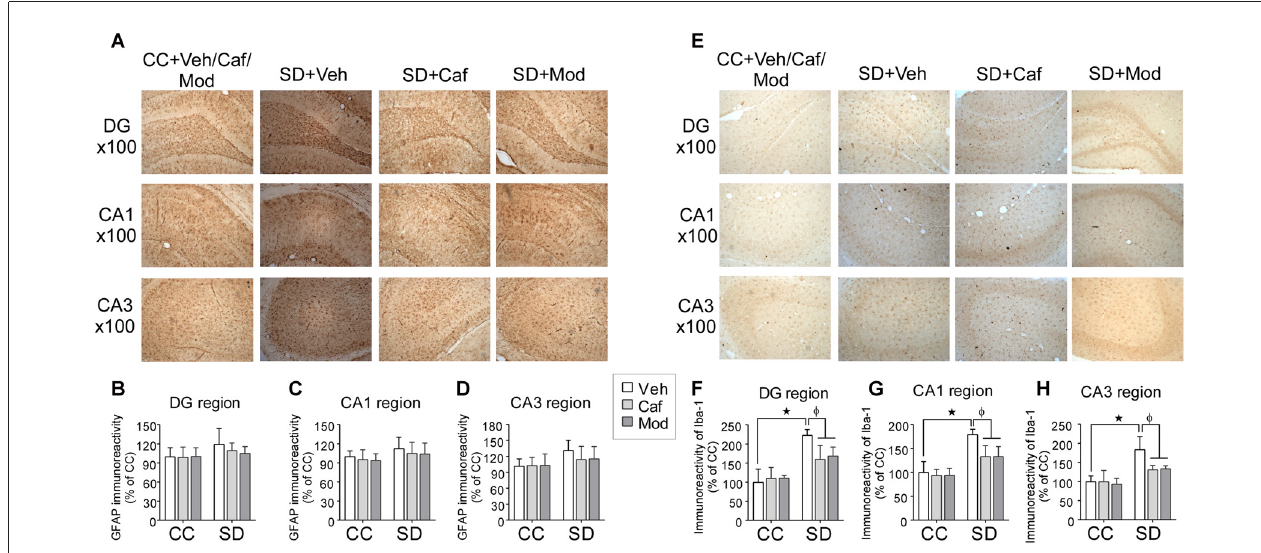
FIGURE 5 | Caffeine or modafinil treatment inhibited the glial cell immunoreactivity in rat hippocampus following SD. (A) Representable image of astrocytes expression in DG, CA1 and CA3 regions of the hippocampus. Glial fibrillary acidic protein (GFAP) immunoreactivity quantification in (B) DG region; (C) CA1 region; (D) CA3 region of the hippocampus. (E) Representable image of microglial cells expression in DG, CA1 and CA3 regions of the hippocampus. Ionized calcium binding adapter molecule I (Iba-1) cell immunoreactivity quantification in (F) DG region; (G) CA1 region; (H) CA3 region of the hippocampus. ∗ p < 0.05 when compared to control treated with vehicle; φ p < 0.05 when compared to sleep deprived treated with vehicle. Two way ANOVA followed by Tukey post hoc multiple comparison test was applied for statistical comparison between groups and for the graphical representation, values expressed mean percentage of Control ± SEM.